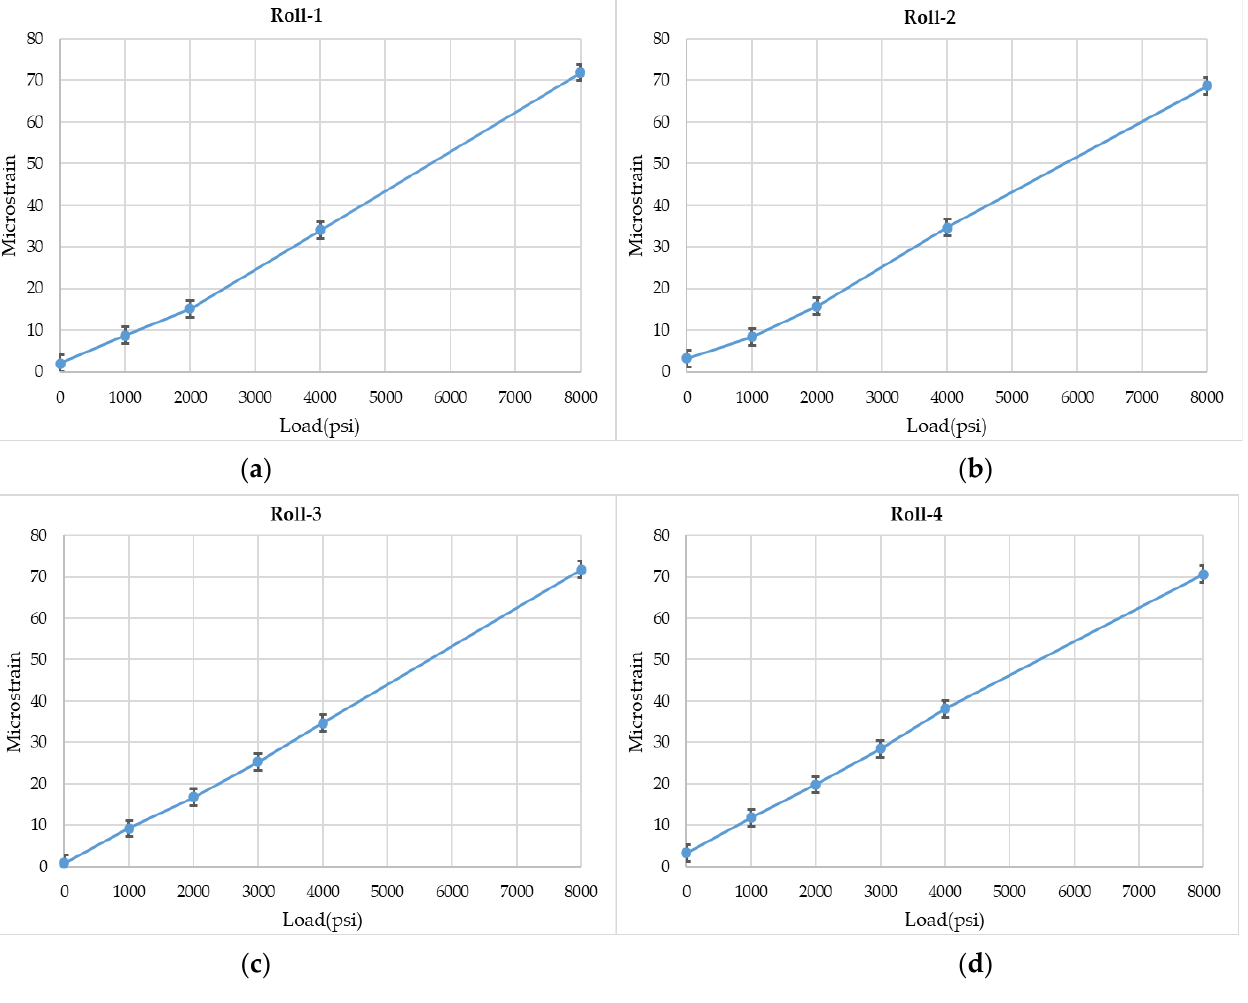
Figure 11. ( a ) Strain measured by Roll-1 for varying loads. ( b ) Strain measured by Roll-2 for varying loads. ( c ) Strain measured by Roll-3 for varying loads. ( d ) Strain measured by Roll-4 for varying loads.